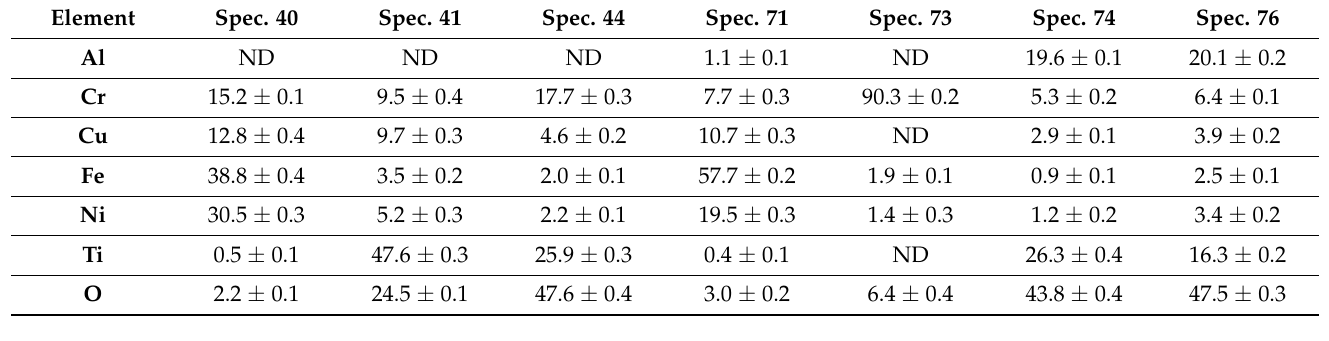
Table 2. Summary chart with chemical analyses (in at. % & deviation) of spectrum shown in Figure 4 (ND = non-detected).